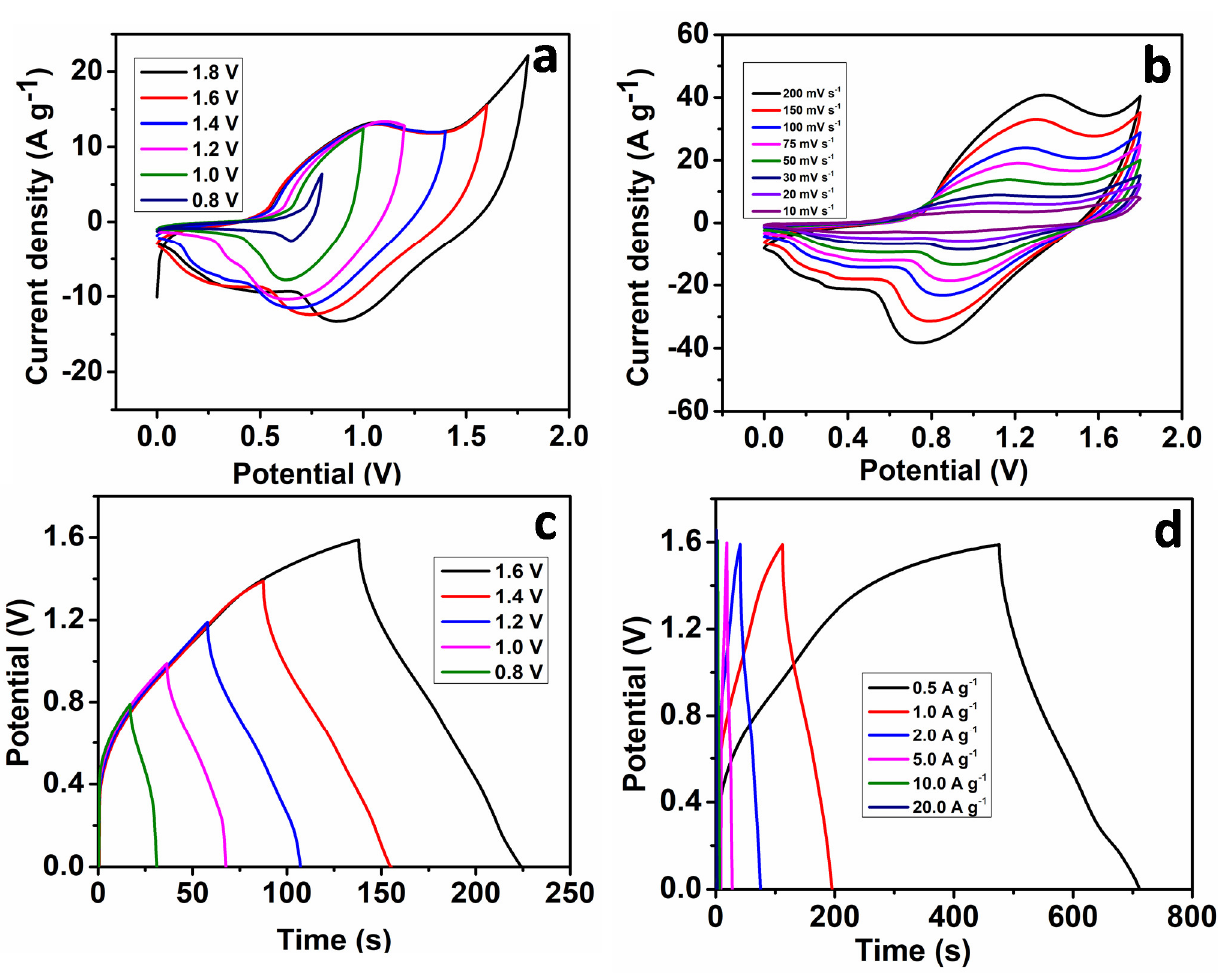
Figure 8. ( a ) CV profiles of NiO//AC ASC device examined at various cut-off windows at a sweep rate of 50 mV s −1 , ( b ) CV profiles of NiO//AC ASC device at various sweep rates, ( c ) GCD curves of NiO//AC ASC device measured at various cut-off range at a current density of 1 A g −1 , and ( d ) GCD profiles of NiO//AC ASC device at various current densities.